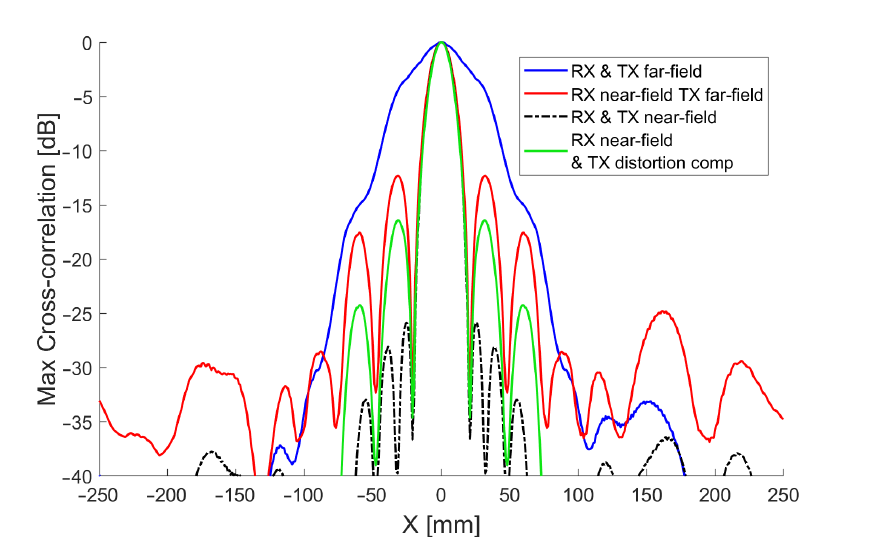
Figure 14. Simulated 60 kHz cross-correlation beam patterns for echoes from a point source reflector located 700 mm from the array employing far-field and near-field beamforming for reception (RX) and transmission (TX). Shown in green is the combined RX near-field and TX distortion compensated beam pattern that was used in this